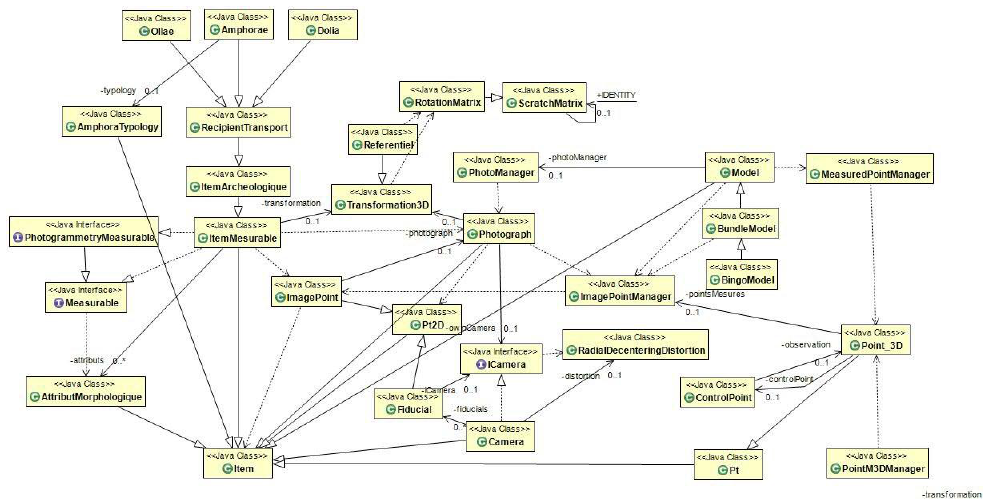
Figure 13. Partial UML diagram of Java classes managing the photogrammetrical process as well as the measured items.